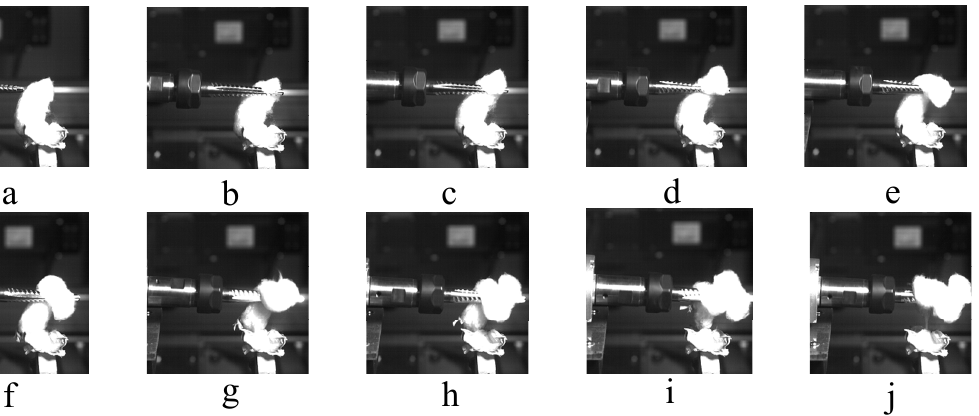
Figure 11. High-speed camera process of the spindle picking a flap of cotton: ( a ) picking spindle and cotton just contact, ( b – c ) hook picking stage, ( d – h ) winding stage, ( i ) cotton fiber and cotton boll shell will be separated, ( j ) the completion of picking.